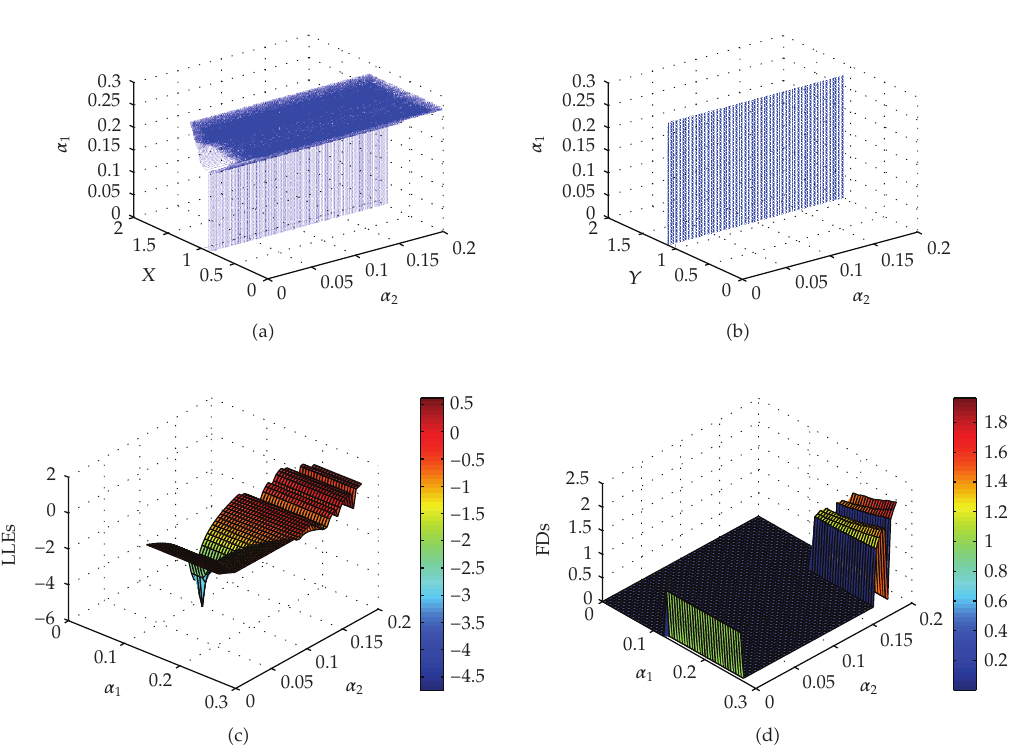
Figure 1: For system (cid:2) 4.2 (cid:3) with α 1 ∈ (cid:4) 0 , 0 . 27 (cid:5) and α 2 ∈ (cid:4) 0 , 0 . 2 (cid:5) , (cid:2) a (cid:3) bifurcation diagram of firms X ; (cid:2) b (cid:3) bifurcation diagram of firms Y ; (cid:2) c (cid:3) largest Lyapunov exponents (cid:2) LLEs (cid:3) ; (cid:2) d (cid:3) fractal dimensions (cid:2) FDs (cid:3) .